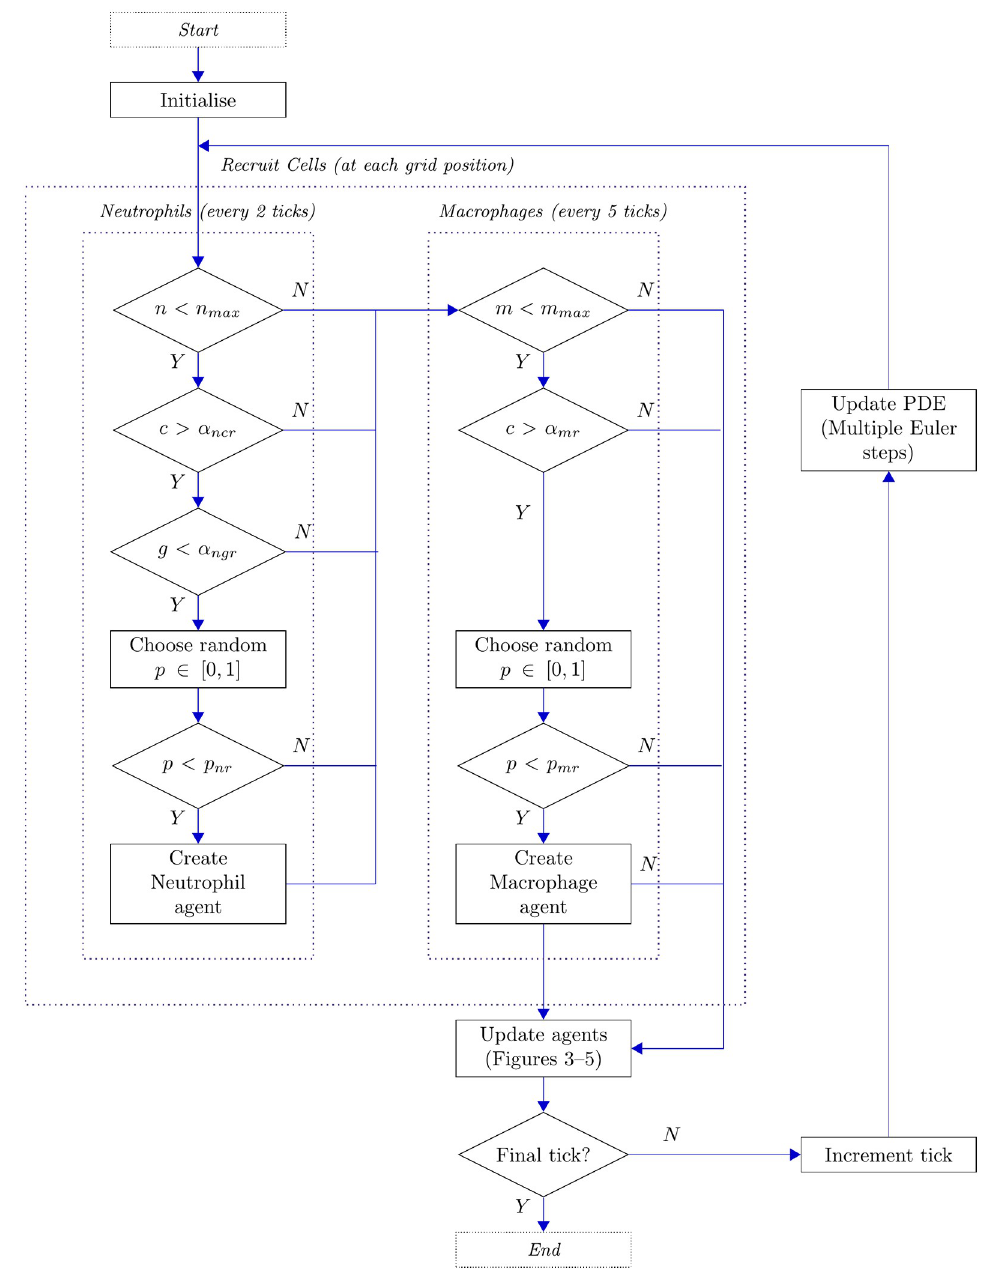
Fig 2. Flow chart illustrating the overarching cell recruitment and update structure of the model. Here, m and n represent the total number of macrophages and neutrophils in the domain respectively.